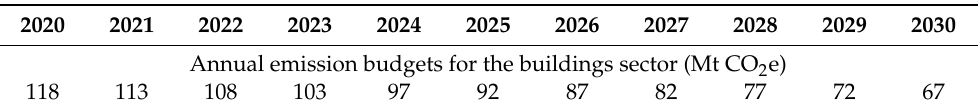
Table 1. Annual emission budgets for the buildings sector specified in the German Climate Change Act.